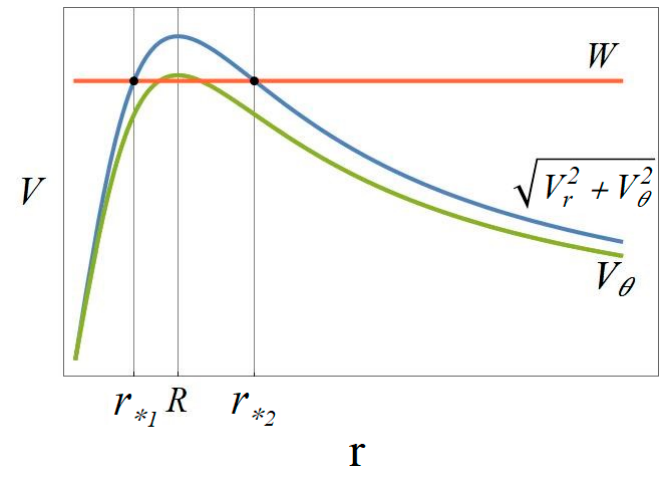
Figure 5. Graphical solution of the first equation of system (4).